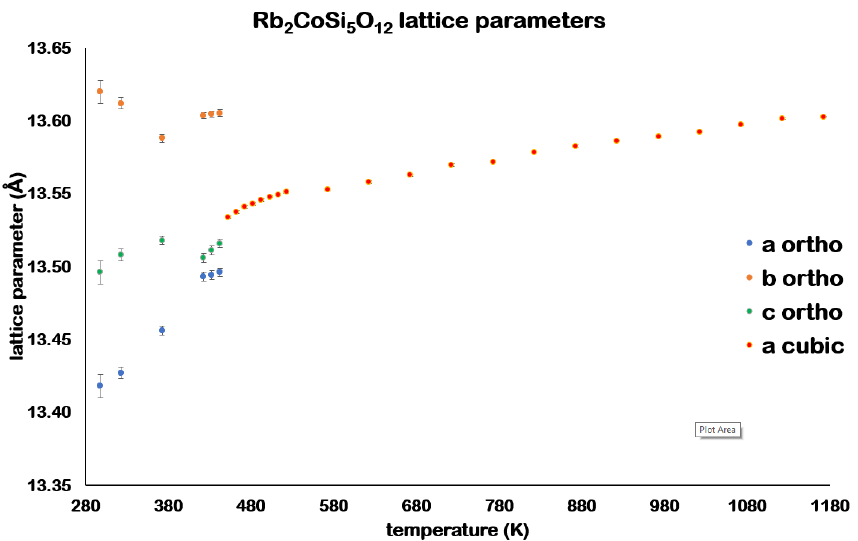
Figure 7. Variation of Pbca orthorhombic a , b and c lattice parameters and Pa 3 cubic a lattice parameter with calibrated temperatures for Rb 2 CoSi 5 O l2.